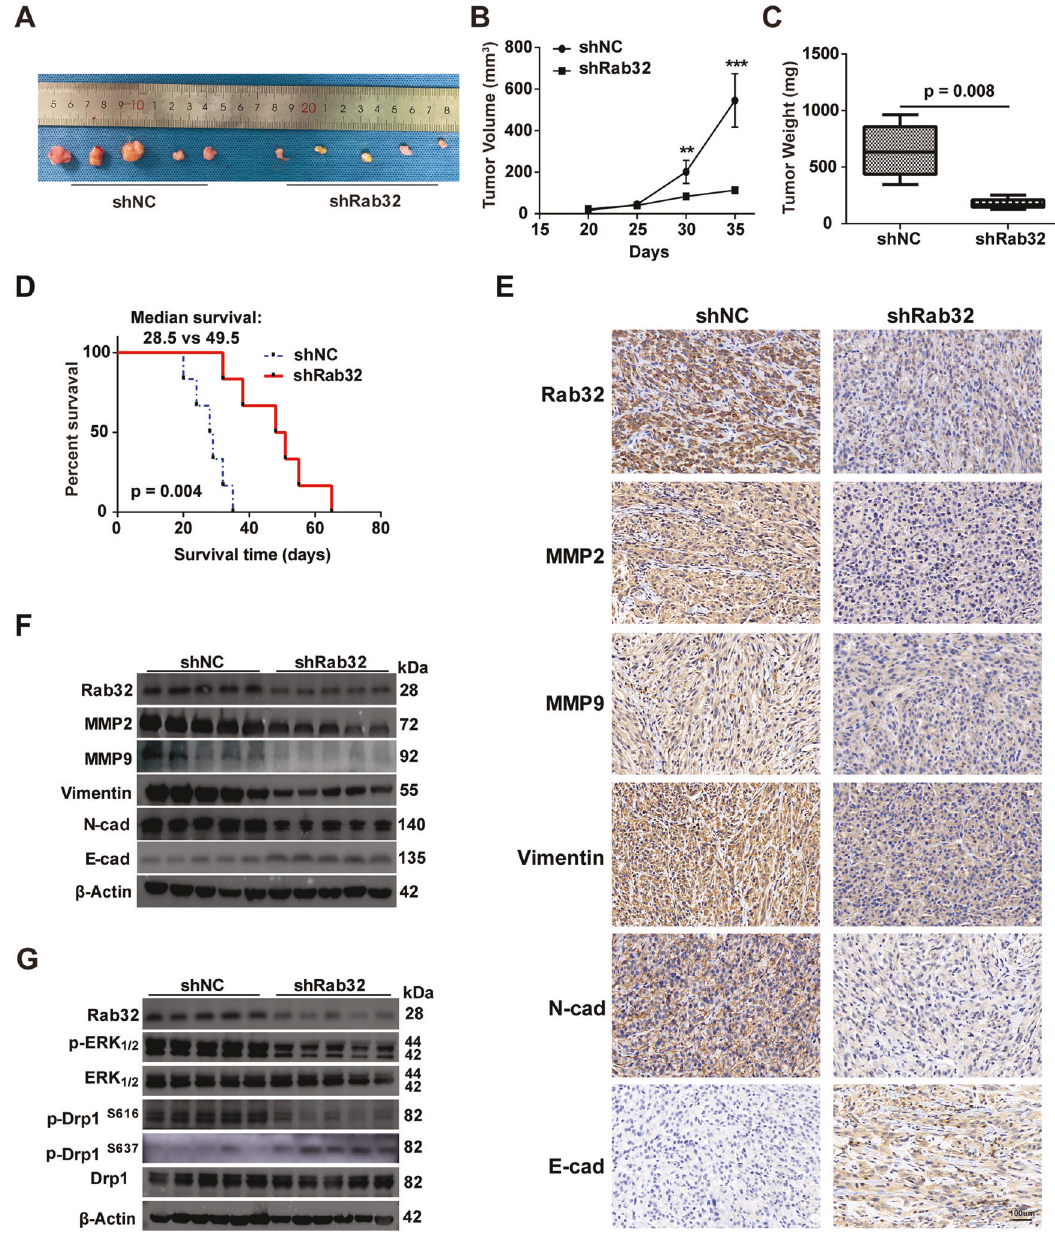
Fig. 8 Downregulation of Rab32 inhibits GBM malignancy in vivo. A Representative images of tumors dissected from each group of mice were taken after nude mice were sacri fi ced. B The tumor volumes were measured and monitored every 5 days from each group of mice. NC or Rab32 silencing- U87 cells were subcutaneously injected into the fl ank of male BALB/c nude mice ( n = 5 per group). C The weights of subcutaneous NC or Rab32 silencing- U87 cells tumors on the 35th day after injection. D Kaplan – Meier survival curve of intracranial in situ xenograft tumor nude mouse model with LV-shNC or LV-shRab32 transfected U87 cells ( n = 6 per group). E Representative images of IHC staining of paraf fi n sections of in situ transplanted tumors in mice for Rab32, MMP2, MMP9, Vimentin N-cadherin, and E-cadherin. Scale bars = 100 μ m. F Western blot analysis of Rab32, MMP2, MMP9, N-cadherin, E-cadherin, and Vimentin in situ xenograft tumors derived from NC- or Rab32 silenced -U87 cells. G Western blot analysis of Rab32, p-ERK 1/2 , ERK 1/2, p-Drp1 S616 , p-Drp1 S637 and Drp1 in xenograft tumors derived from NC- or Rab32 silenced -U87 cells. β -Actin was used as loading control. All data are shown as the mean ± SD of three replicates. ** P <0.01, *** P